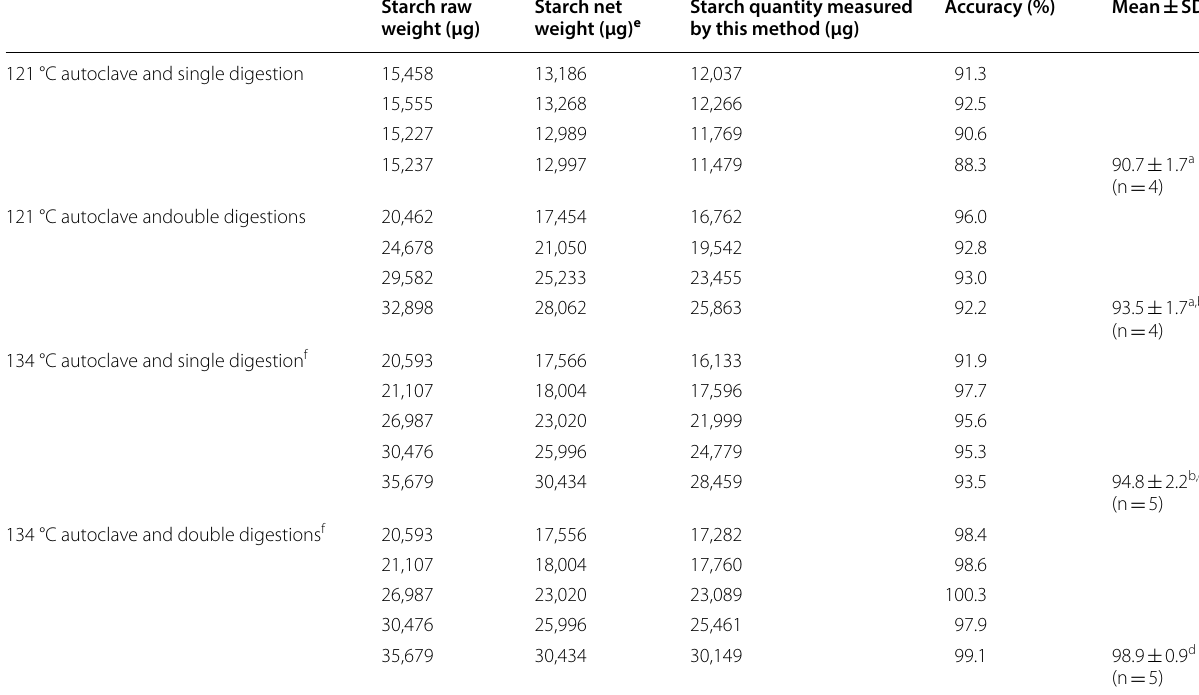
Table 1 Effects of autoclaving temperature and enzymatic digestion duration on the accuracy of starch measurement using this